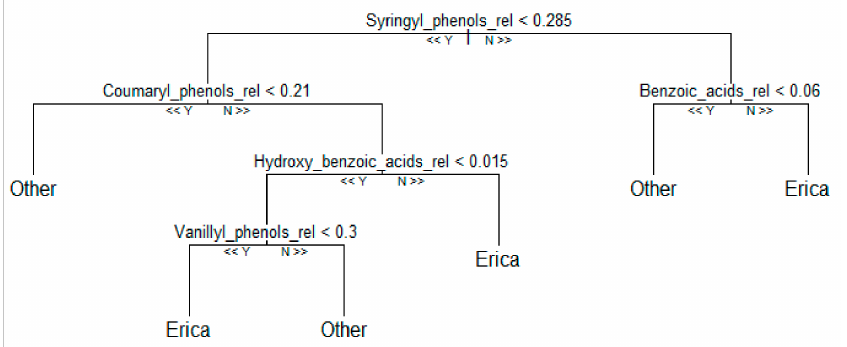
Figure 8. Representative decision tree of Random Forest model using relative phenols contribution. 32 training sample sets and 10,000 number of trees were used to compute the model.